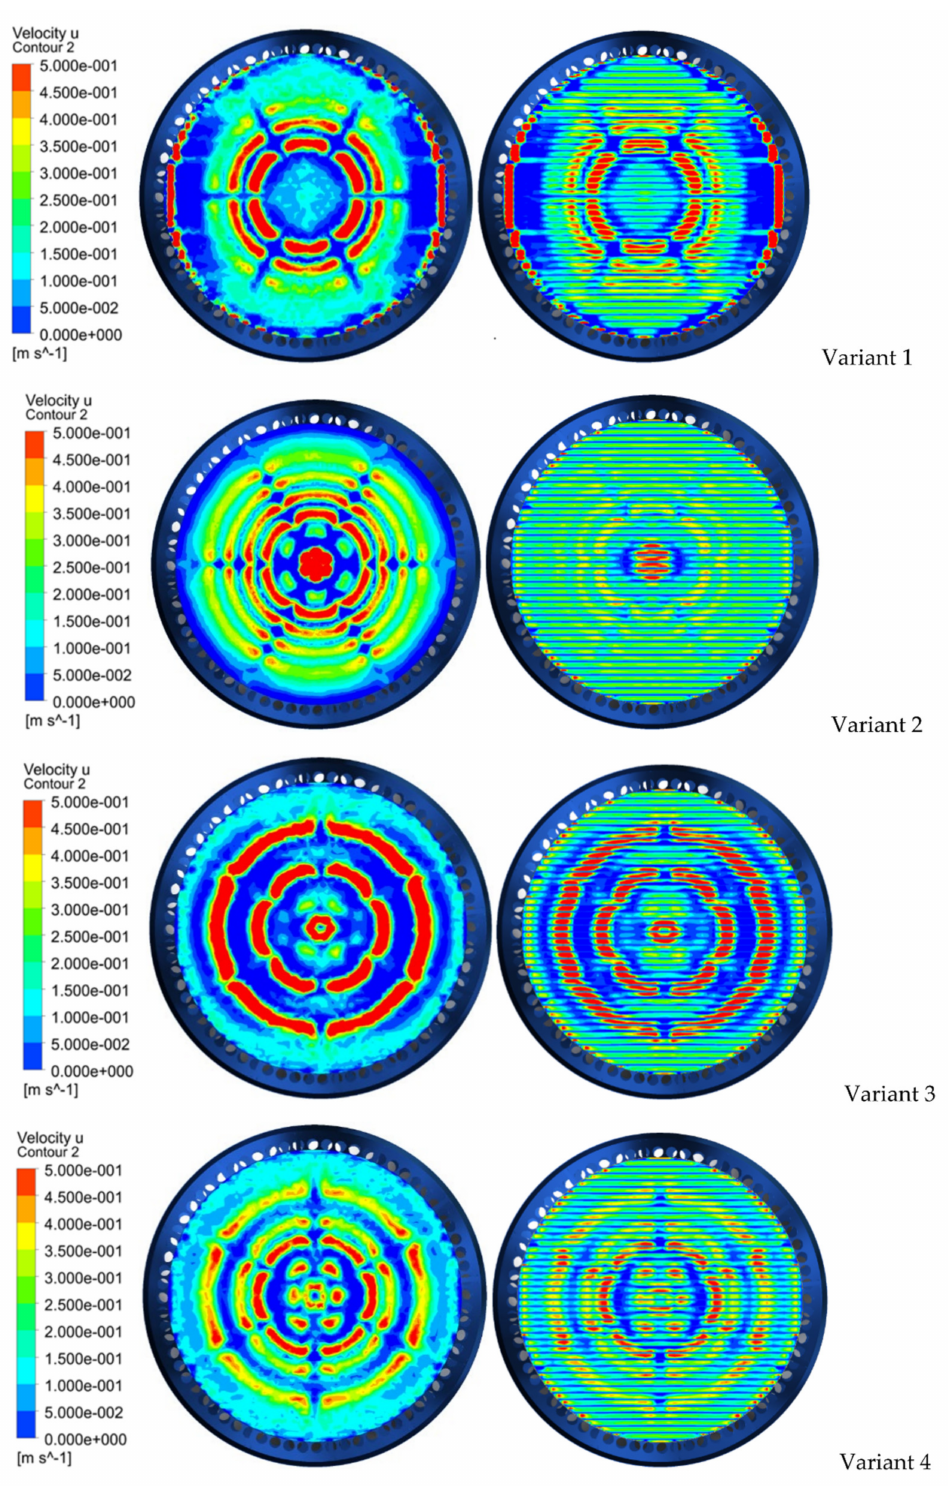
Figure 13. Velocity distribution in cross-sections perpendicular to symmetry axis, 1 mm in front of pleats ( left ) and 1 mm behind front pleat edges ( right ). The pleat height is 13.5 mm and the spacing is 2